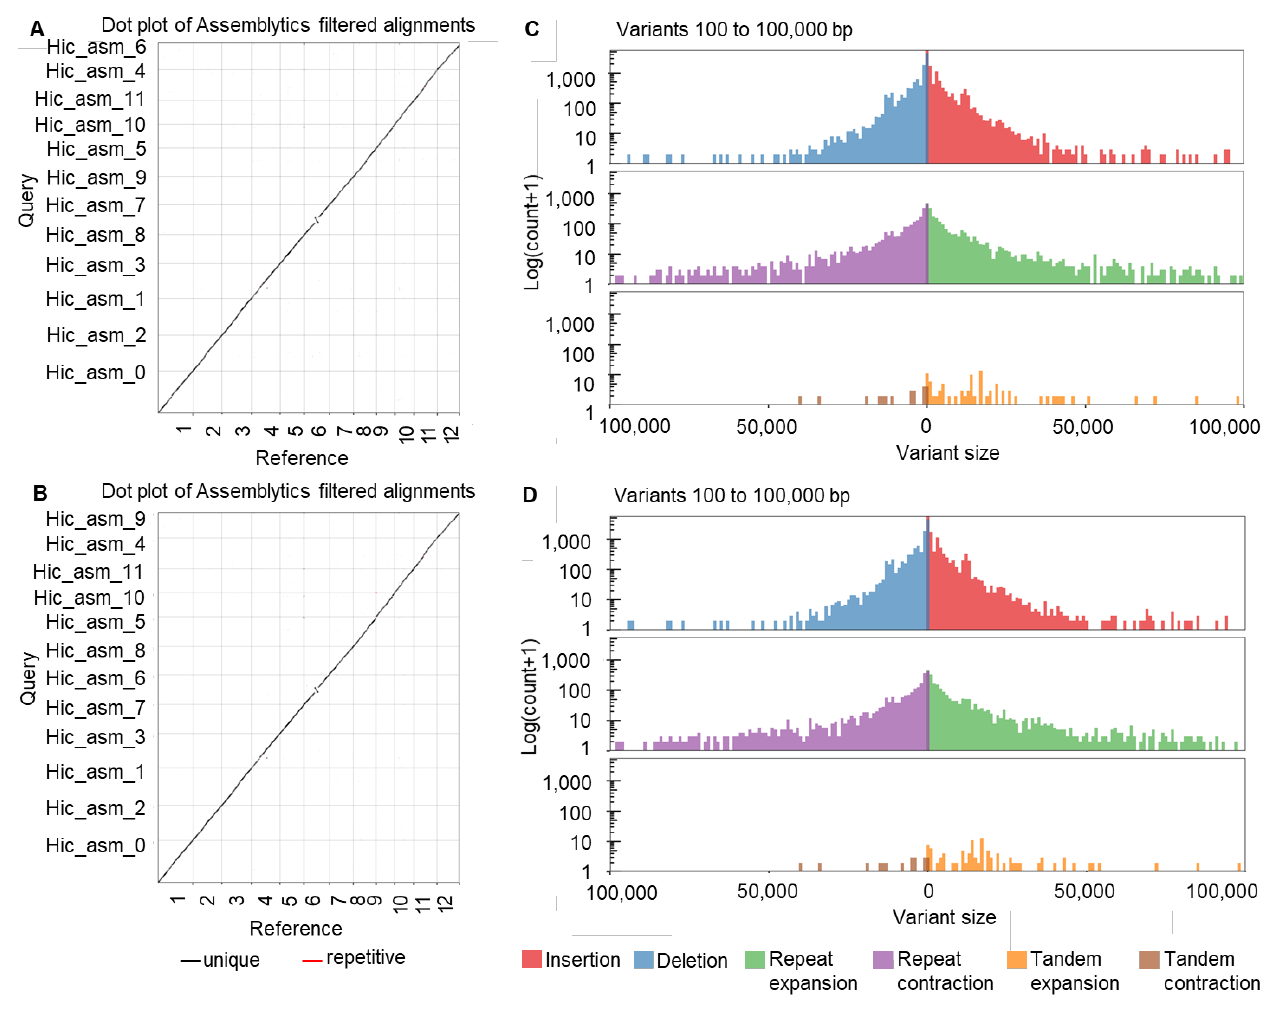
Figure 1. Comparative genome analysis of R21 and Jin Hui 1. ( A , B ) Comparative analysis of assembled genomes with rice reference genome IRGSP-1.0 of R21 ( A ) and Jin Hui 1 ( B ); ( C , D ) Variation analysis of assembled genomes of R21 ( C ) and Jin Hui 1 ( D ).